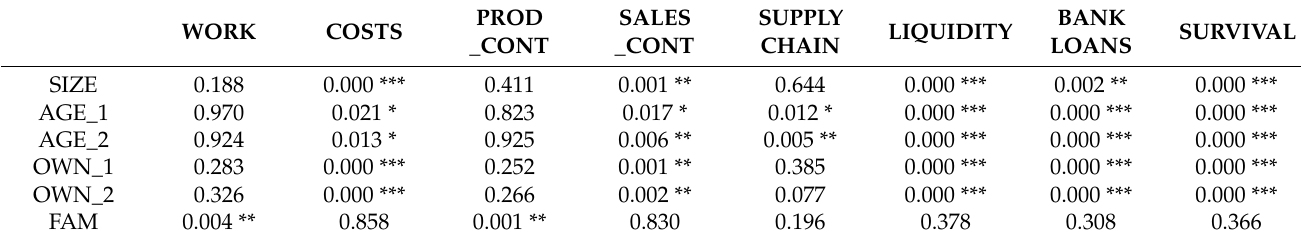
Table 3. Results of ANOVA ( p -values of Kruskal–Wallis test).